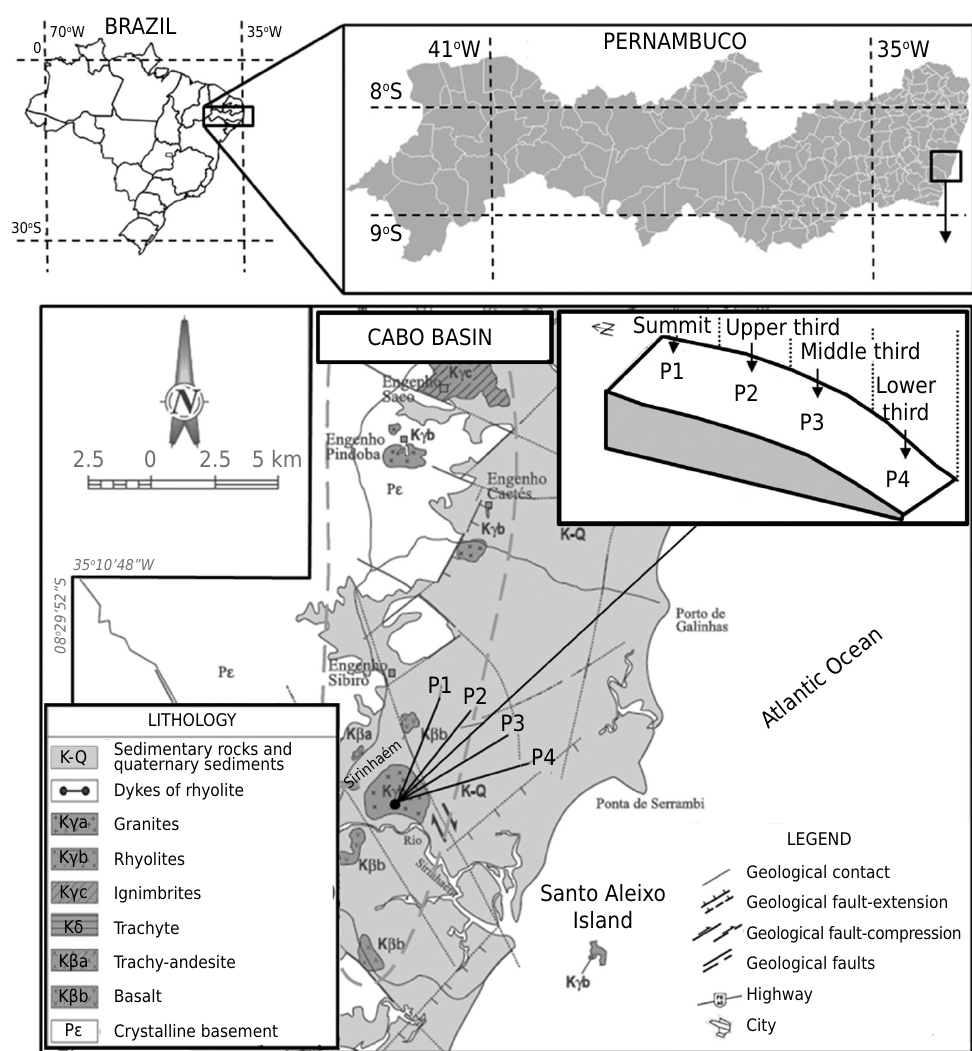
Figure 1. Location of the profiles in the volcano-sedimentary basin of Cabo (Modified from Lima Filho,